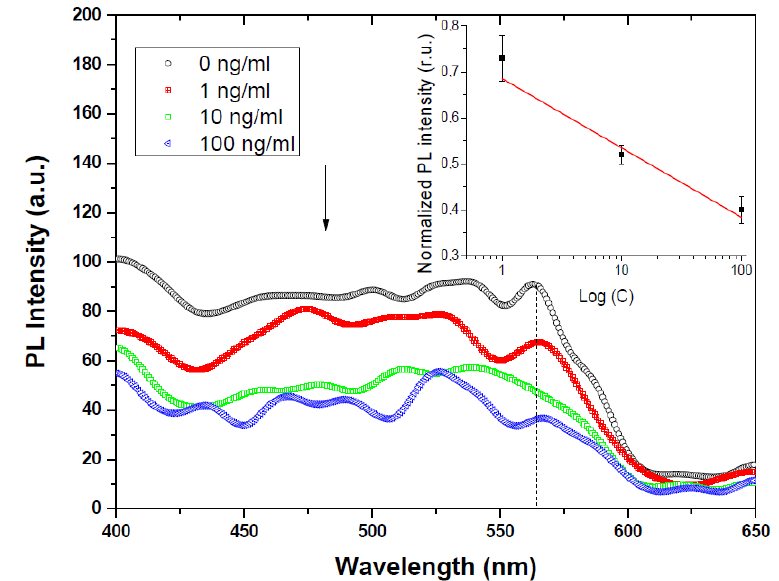
Figure 5. PL response of p-type PSi / ZnO toward di ff erent AFB1 concentrations. The inset graph indicates the linearity of PL response to three di ff erent concentrations of AFB1 in a half-logarithmic scale with an error